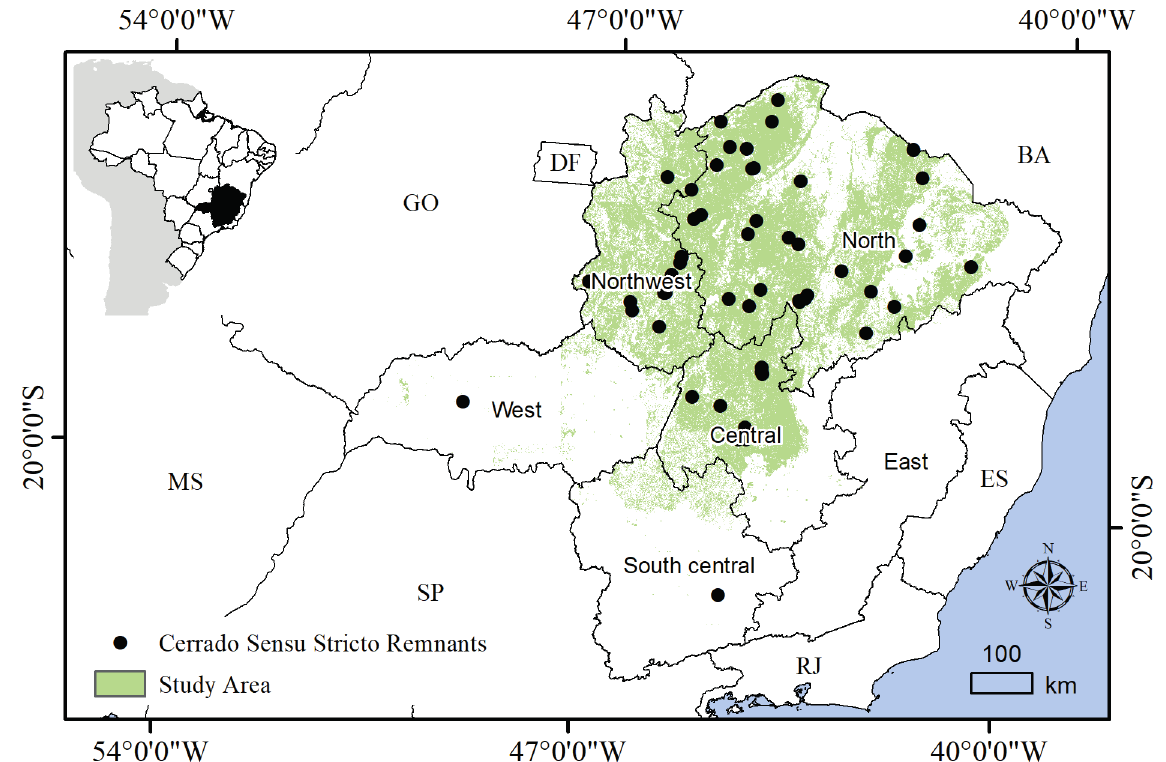
Figure 1 - Location of the state of Minas gerais in Brazil and remnants of Cerrado Sensu Stricto measured by the project Forest Inventory of Minas Gerais